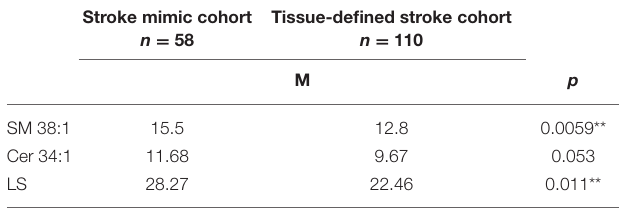
TABLE 5 | Lipid biomarker levels in stroke mimic and tissue-defined stroke cohorts. Stroke mimic cohort n =